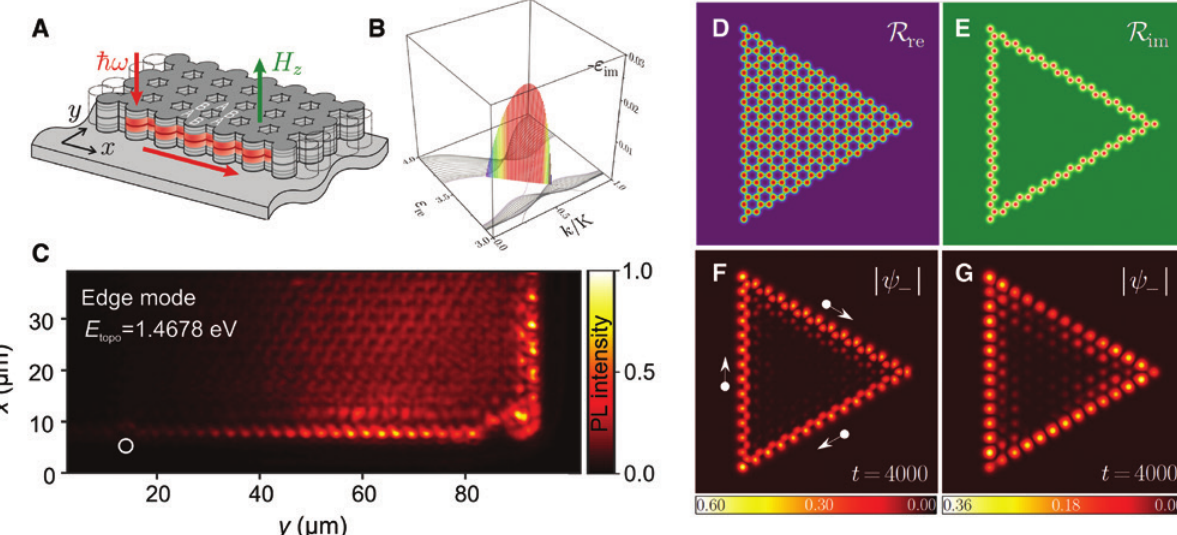
Figure 7: 2D topological polariton lasers. (A) Scheme of polariton micropillars arranged in hexagonal shape under external magnetic field. (B) Real and imaginary part of eigenmodes for a hexagonal structure with finite-y and infinite-x size. Color bar shows that the edge mode experience amplification where − ε < 0 is set to zero in the plot. (C) Exciton-polariton topological edge state observed in photoluminescence experiment in the lasing All − ε im regime. (D, E) Real and imaginary part of the photonic potential for a triangular-shaped lattice with the gain confined at the boundary. (F) Calculated unidirectional edge mode lasing profile under external magnetic field in the steady-state with arrows indicating the current direction. (G) Simulation of lasing from a trivial bandgap structure (zero spin-orbit coupling) where only sites in one sublattice emit ((A) Replicated from Ref. [76], (C) replicated from Ref. [32], and (B, D–G) from Ref.